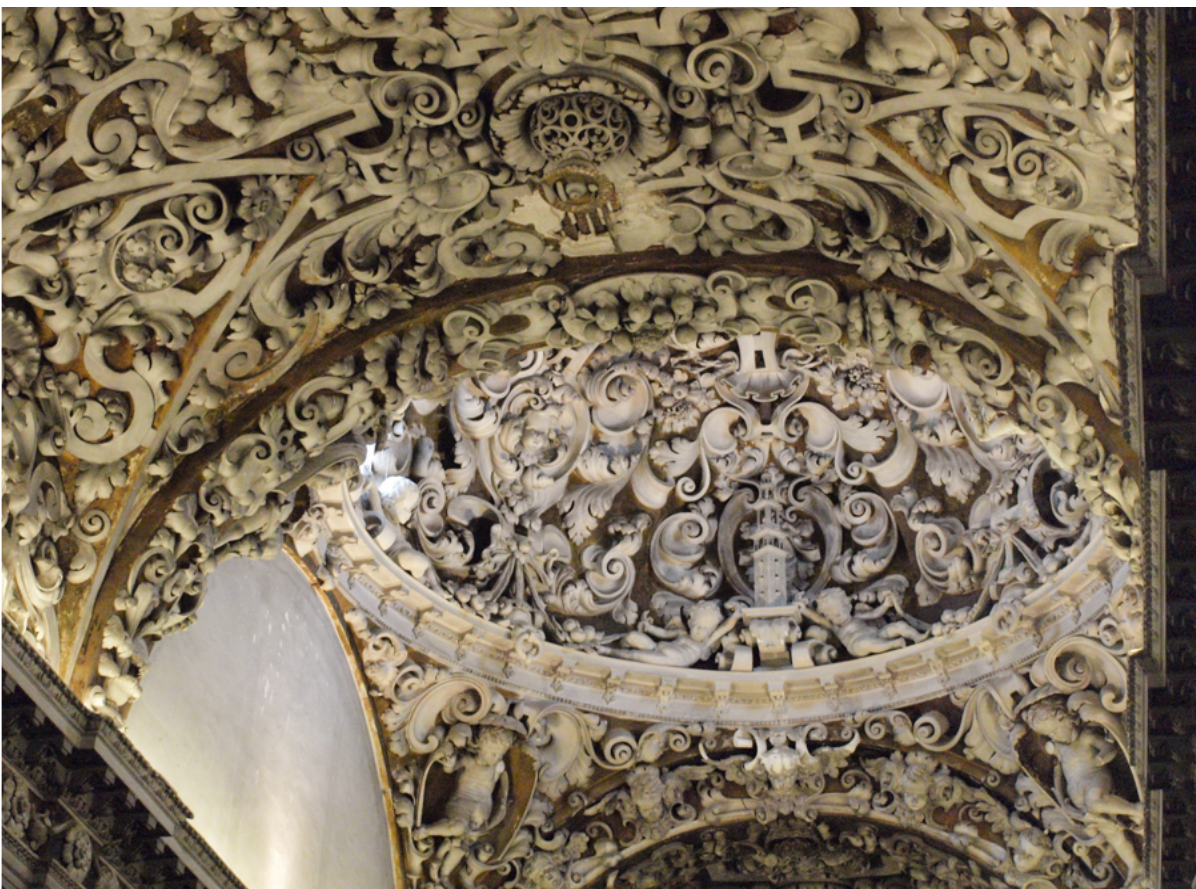
Figure 10: The yeserias on the vaults of the church of Santa María la Blanca, Seville. Image from http://www.flickr. com/photos/isanet/8591929451/in/faves-76073360@N08/. Photo by Isabel Moguer (Creative Commons